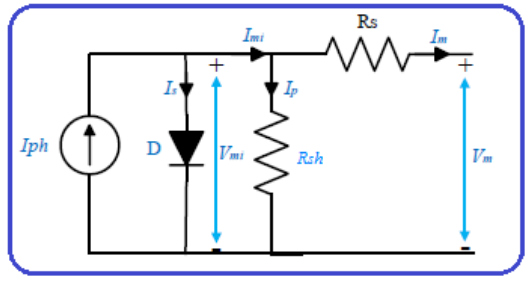
Figure 2. Single-diode PV cell model.